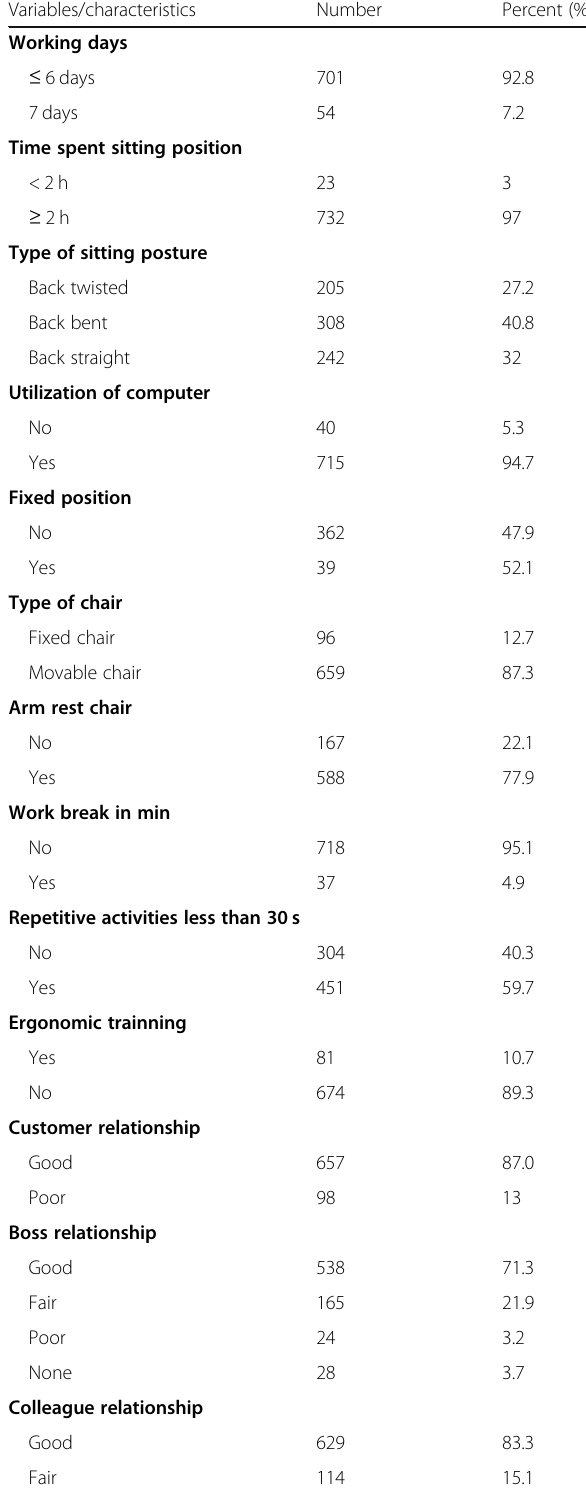
Table 3 Working environment, ergonomic characteristics, and psychosocial factors of bank workers in Addis Ababa, April 2018